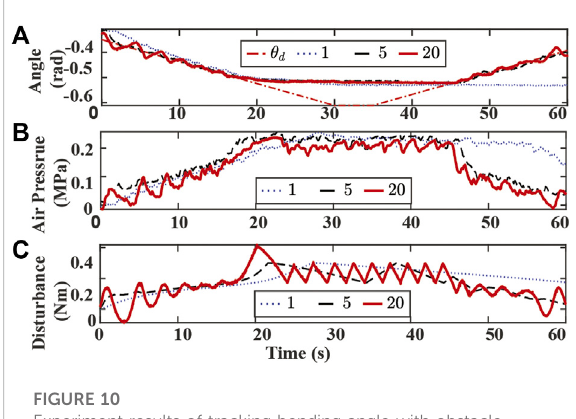
FIGURE 10 Experiment results of tracking bending angle with obstacle and changing k w . (A) Bending angle tracking results where θ is the originaldesired(dash-dotted red),andk w aresetto1(dottedblue), 5 (dashed black), 20 (solid red), respectively. (B) Air pressure measurements of chamber 1. (C) Lumped disturbance